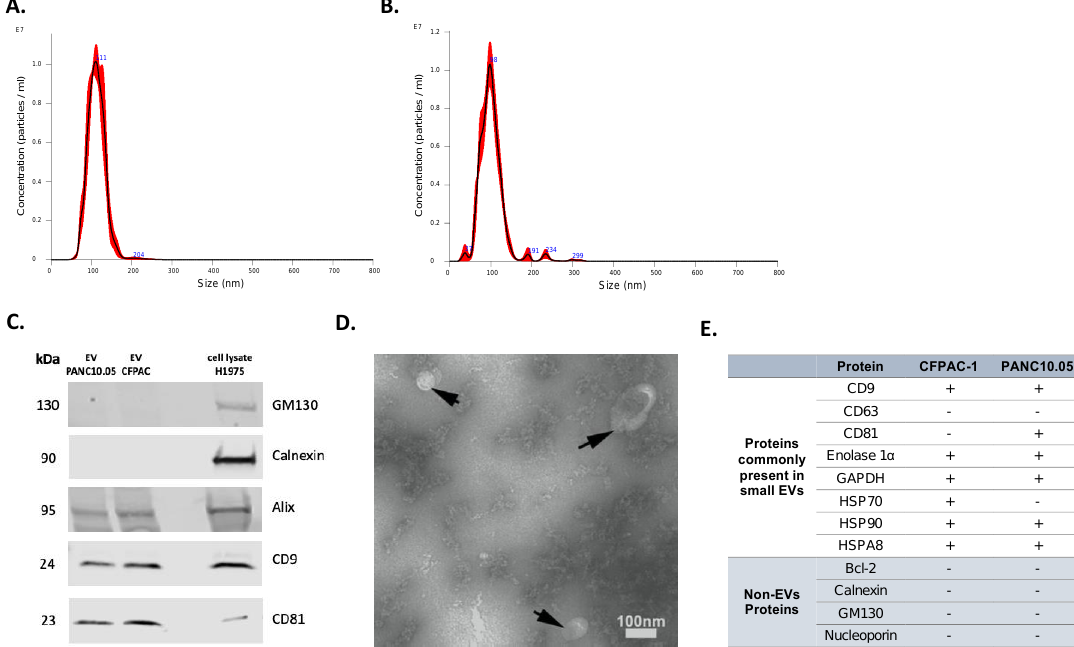
Figure 1. Characterization of EVs isolated from CCMs. Representative NTA histograms of EV samples isolated from ( A ) PANC10.05 and ( B ) CFPAC-1 CCM. ( C ) Representative Western blots of EV markers CD9, CD81, and Alix, and of non-EV markers Calnexin and GM130 for EV samples isolated from CCMs derived from CFPAC-1 and PANC10.05 cell lines (H1975 cell lysate was used as a control). ( D ) Representative TEM image of CCM-derived EV sample. ( E ) MS analysis of EV-positive and -negative markers of CFPAC-1- and PANC10.05-derived EVs.